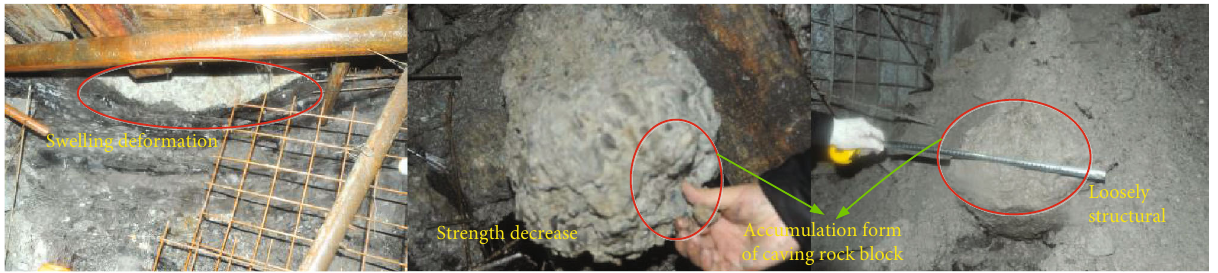
Figure 1: Location and generalized stratigraphic column of 1802 tailentry.